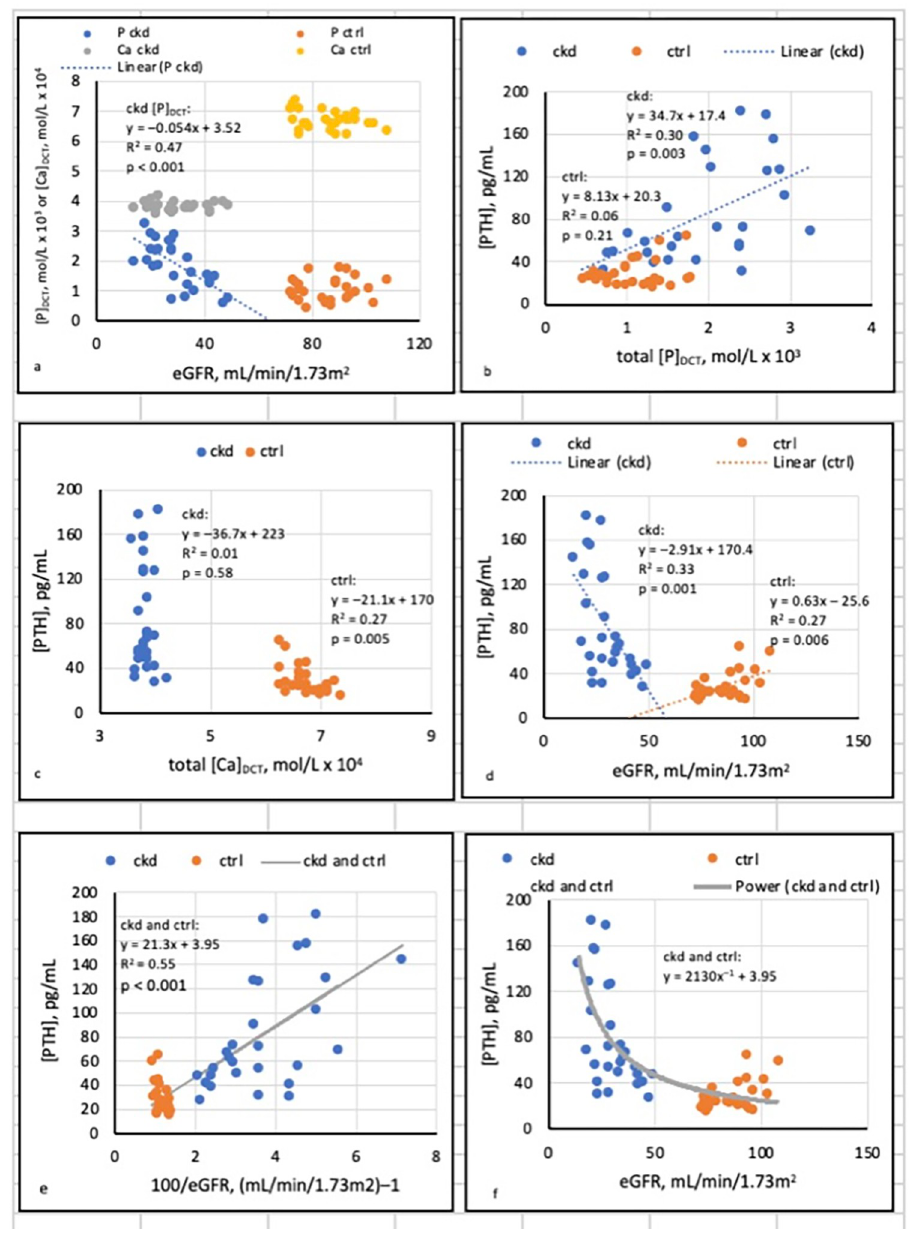
Fig 1. Linear regressions unaffected by pH or precipitation of Ca 3 (PO 4 ) 2 (am.,